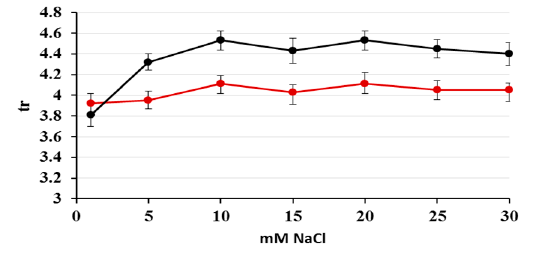
Figure 1. Chromatograms illustrating influence of NaCl in the mobile phase on the parameters of NO 3 − ( A ) and NO 2 − ( B ) peaks. The column was IAM.PC.DD2 Regis HPLC Agilent Technologies, the flow rate of the mobile phase was 0.5 mL/min, the injected volume 3 µL, and the analytical wavelength of 210 nm. The abbreviation k stands for retention factor, A s denotes the symmetry factor and N is the theoretical plate number.